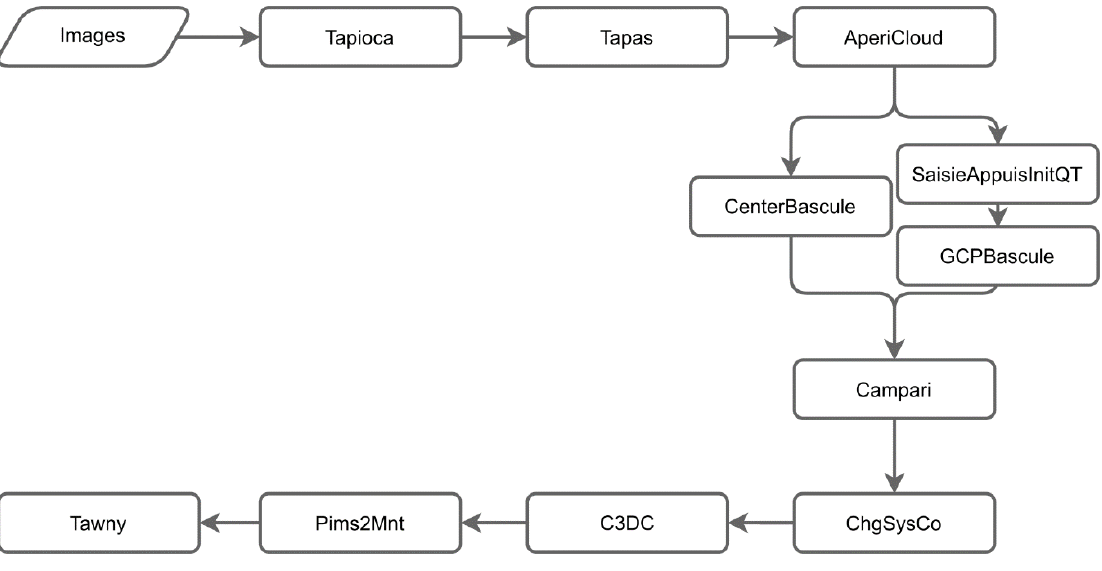
Figure 5. MicMac workflow.